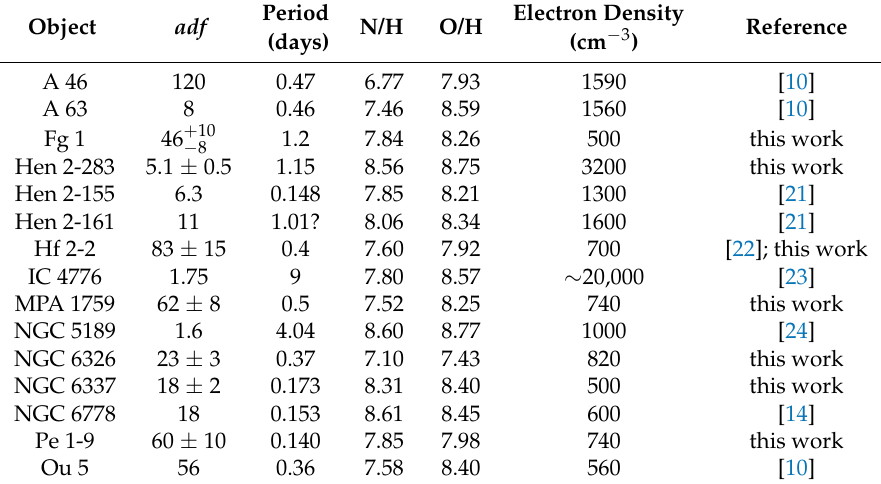
Table 1. Properties of the 15 nebulae with close binary central stars and a measured adf